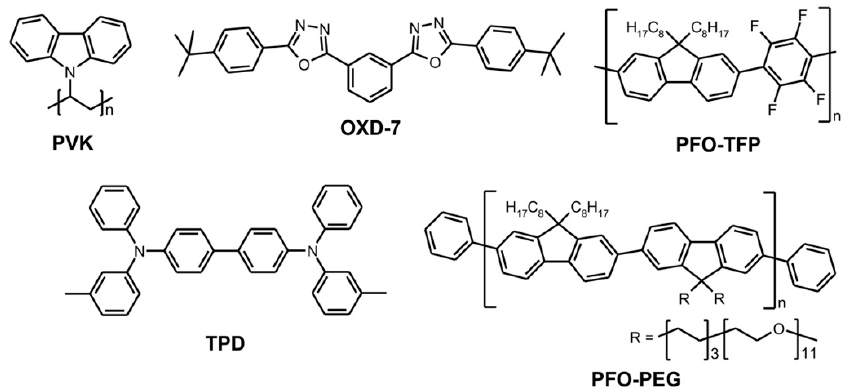
Figure 2. Chemical structures of compounds used for the fabrication of the devices.